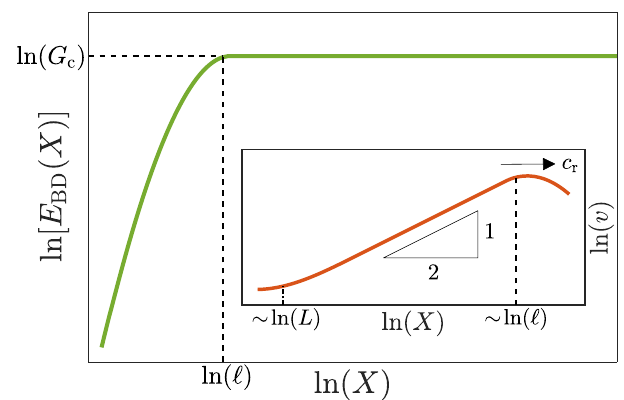
Fig. 1 Scale separation and singularity order in conventional cracks. A schematic illustration of dissipation-related lengthscale separation and singularity order in conventional cracks. The breakdown energy E BD is plotted as a function of the distance X behind a propagating crack (see inset), in a logarithmic scale. The breakdown energy E BD quanti fi es the energy dissipation associated with crack propagation and is given by E ð X Þ ¼ G ð Δ E ð X Þ þ 1 Þ , where the spatial integral Δ E ð X Þ is given in BD c BD BD Eq. (1) and G c is the fracture energy (de fi ned in the text). E BD ( X ) increases over the spatial range 0 < X < ℓ (i.e., inside the so-called cohesive/process zone 29,30 ), but saturates at E BD ( X ) = G c for X ≥ ℓ (see dashed lines). That is, conventional cracks feature strict scale separation, where dissipation occurs only on a localization length ℓ . (inset) A schematic illustration of the slip velocity fi eld v ( X ) behind a crack propagating at an instantaneous velocity _ L ¼ c r from left to right ( L is the crack length and the dot stands for a time derivative. In addition, note that X here is increasing from right to left, unlike the main panel). v ( X ) features the conventional linear elastic fracture mechanics (LEFM) (cid:1) 1 singularity (see triangle and note the 2 logarithmic scale) on intermediate scales, ℓ ≪ X ≪ L . This square root singularity is directly related to the strict dissipation-related lengthscale separation illustrated in the main